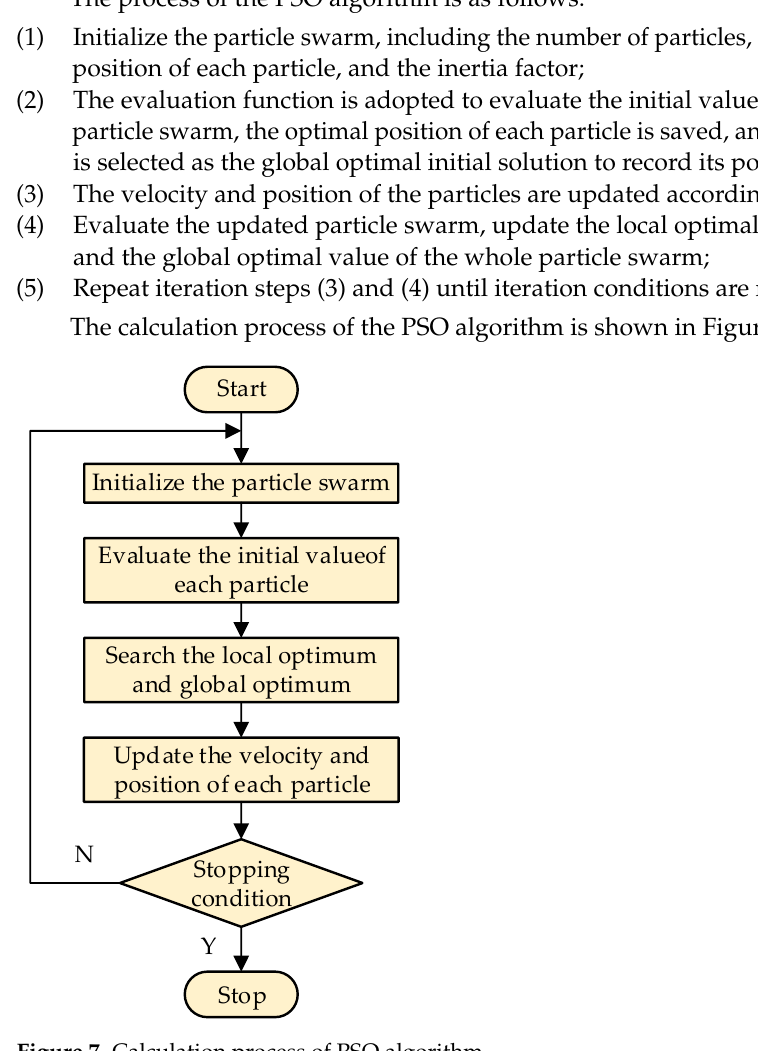
Figure 7. Calculation process of PSO algorithm.